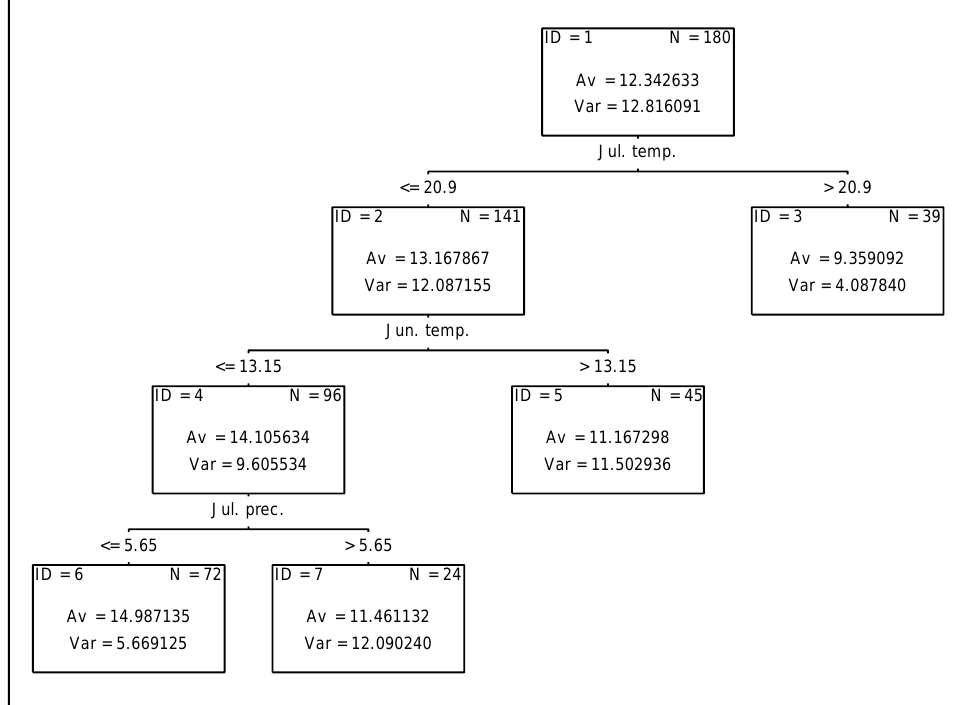
Figure 9. Diagram of regression tree reflecting nitrogen acquisition from fertiliser by soybean plants treated with Improver.